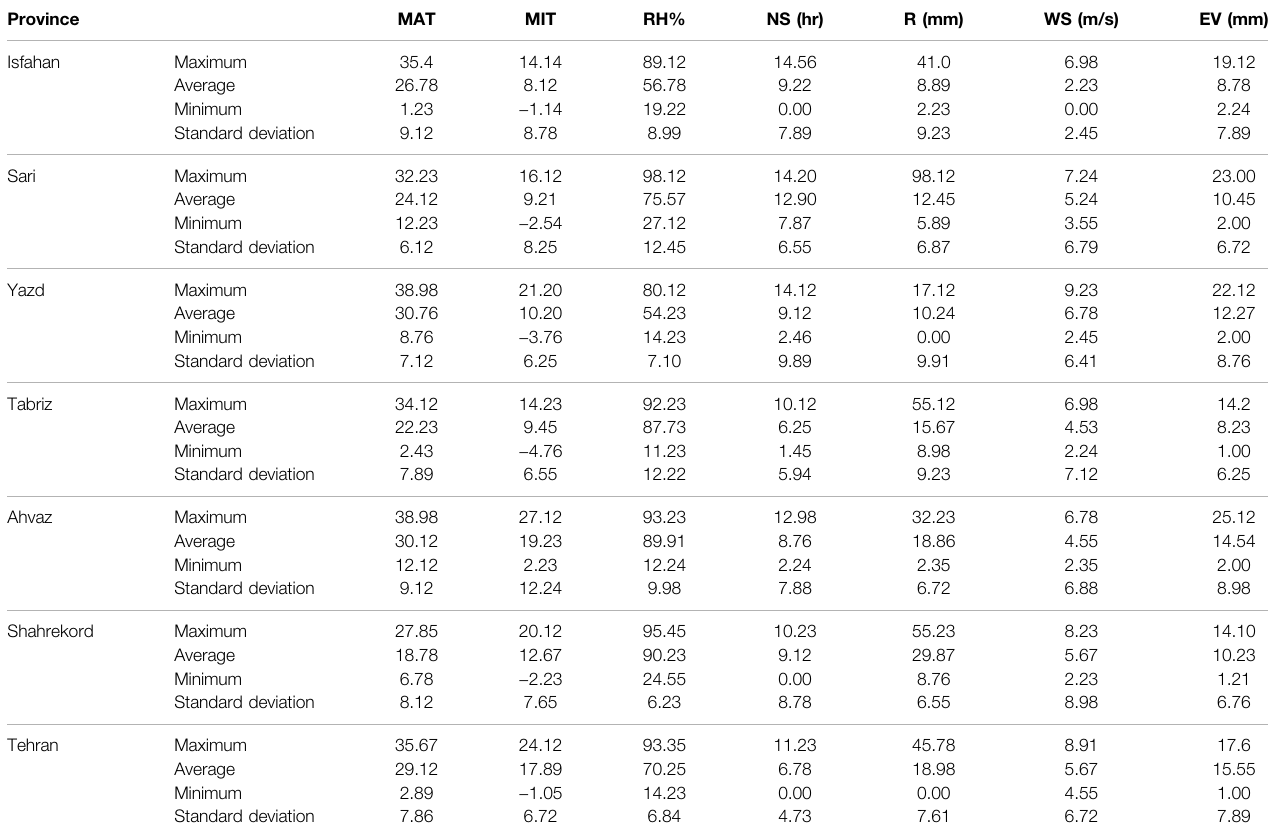
TABLE 1 | The characteristics of